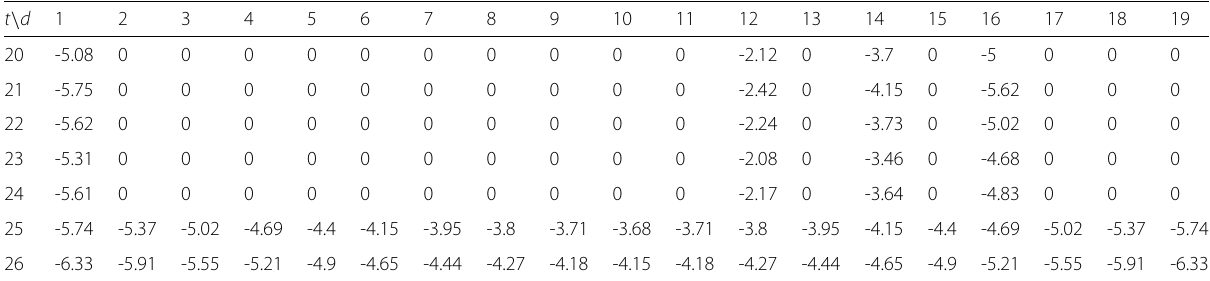
Table 12 Optimal values of A